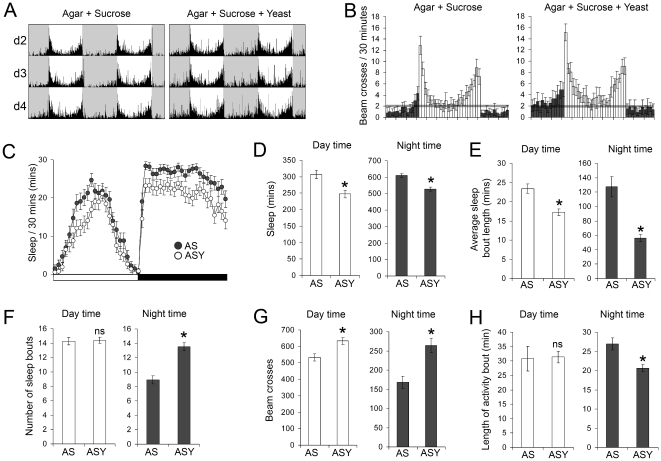
Effects of dietary yeast extract on sleep-wake behaviour of male Drosophila.Male w1118 flies were housed in polycarbonate tubes and provided with agar containing 5% sucrose (AS) or agar, 5% sucrose and 2% yeast extract (ASY). Locomotor activity was recorded as the number of times a fly broke the path of an infra-red beam at the midpoint of the tube. Periods of 5 minutes without beam crossing were regarded as a single period of sleep. (A) Actograms showing averaged beam crossing data for three consecutive days (d2, d3 and d4). The light and shaded areas denote the 12-hour periods of light and darkness of the 24-hour cycle. A single day's data is re-plotted on the following line so that the relationship between the light-dark cycle and the rhythm of locomotor activity can be seen better. (B) Averaged beam crossing data binned to every half-hour of the 24-hr cycle for flies fed the different diets; dark bars represent night and day activity, respectively. The grey bar denotes an average of 2 beam crosses per half hour and is presented to aid comparisons of the data. (C) Minutes of sleep per 30 minutes. The white and black bar represents the 12 hour light and dark phases of the 24 hour cycle. (D) Total amount of time spent asleep for flies fed the agar-sucrose (AS) and agar-sucrose-yeast (ASY) diets. (E) The average length of each sleep bout by flies fed the different diets. (F) The mean number of sleep bouts. (G) The amount of locomotor activity undertaken by flies on the different diets. (H) Average length of activity bouts. *P<0.01; #P<0.05; n = 32 flies for each diet in A, B and C; rest of data is n = 100 flies for each diet, data was pooled from five independent trials.